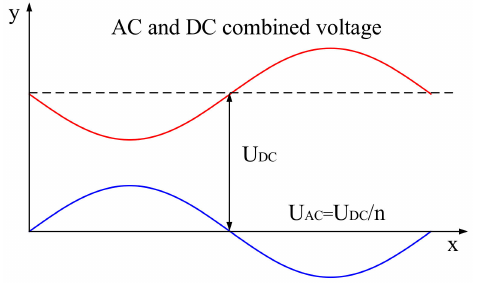
Figure 3. Applied voltage waveform.